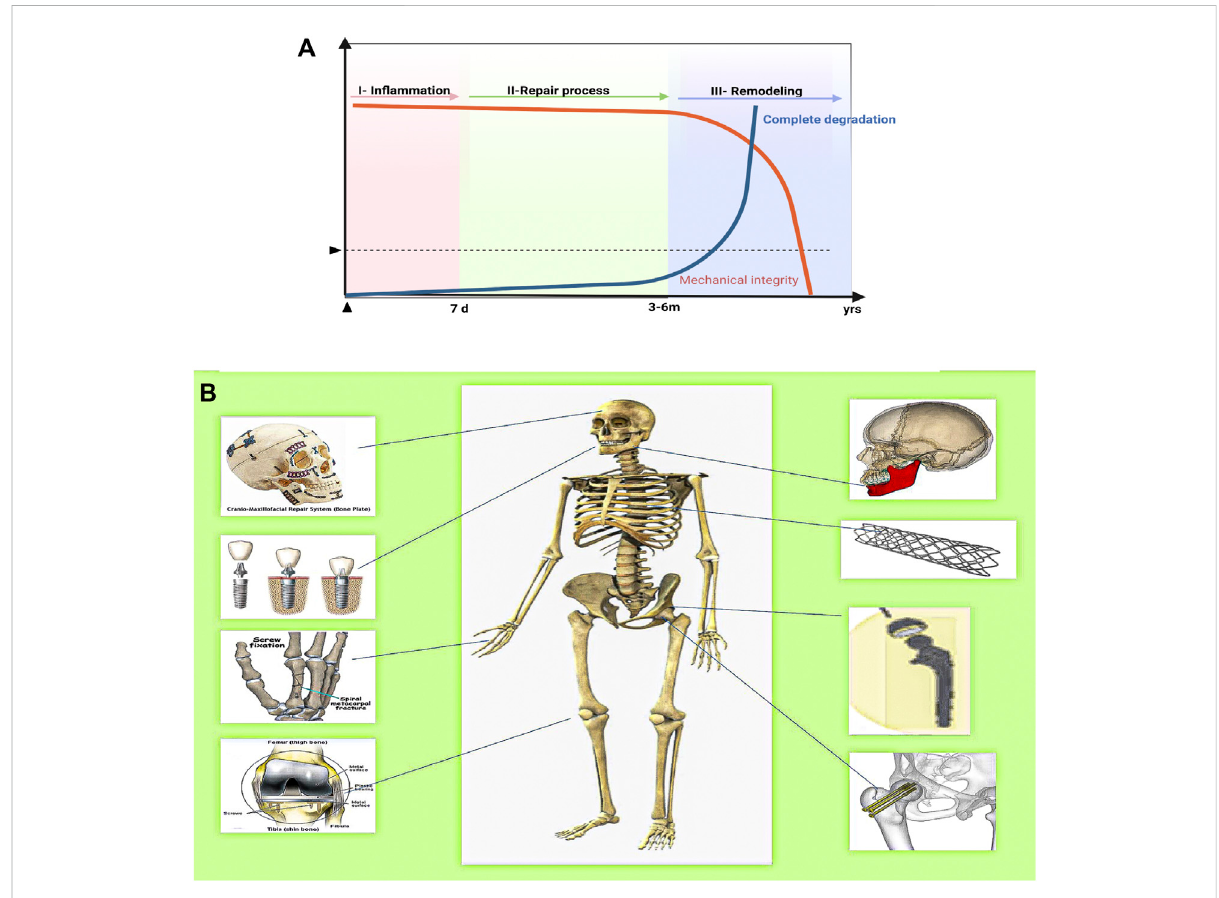
FIGURE 7 Theidealbiomechanicalstrengthcurve,bonehealingprocess,andMgalloysfortherepairofbonedefectsindifferentareasofthehumanbody. (A) The ideal compromise curve between the mechanical integrity of the biodegradable metal implant, biodegradation rate, and fracture healing process. (B) Application of Mg alloy bioimplants in humans depending on the area affected by the